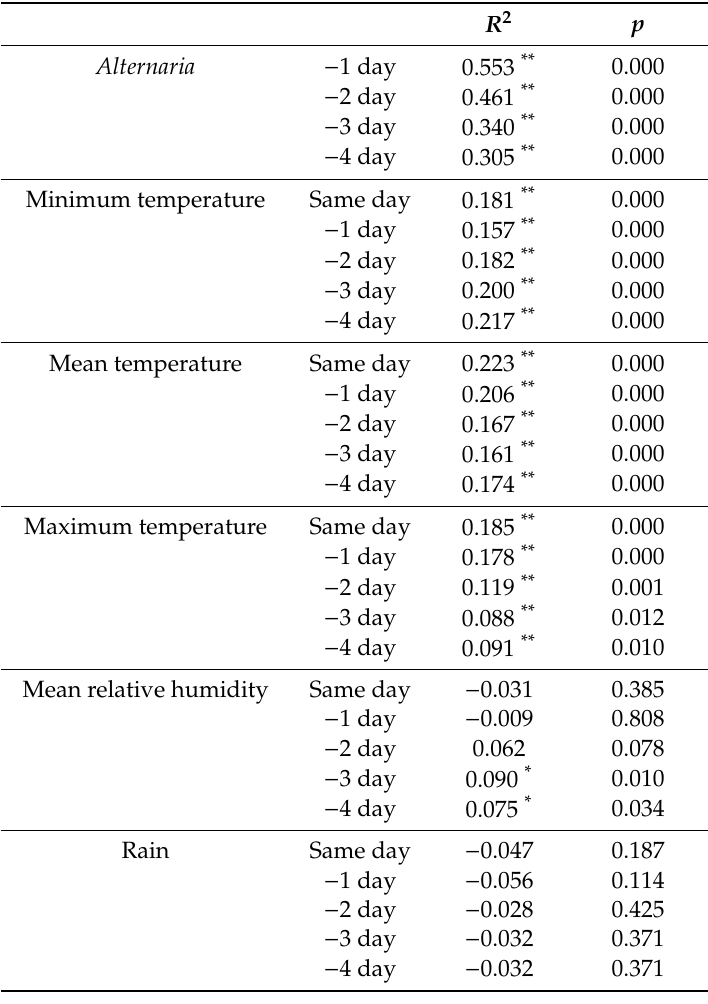
Table 3. Spearman correlation coe ffi cients between Alternaria concentration and weather parameters, and Alternaria concentration of the same day, and on 1 to 4 days prior ( − 1, − 2, − 3, and − 4). ** p < 0.01; * p < 0.05.